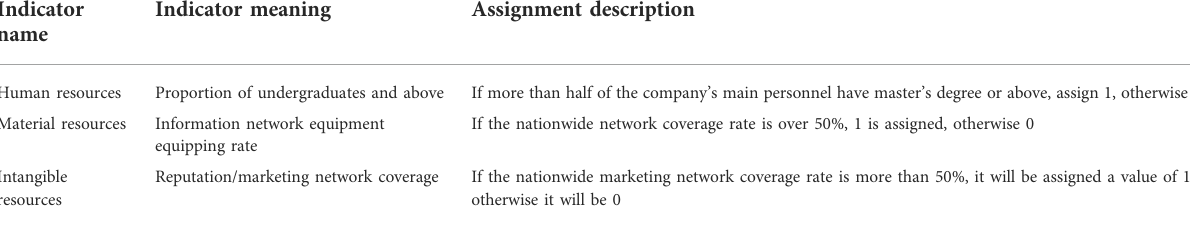
TABLE 4 Judgment standard of critical resources of service-oriented